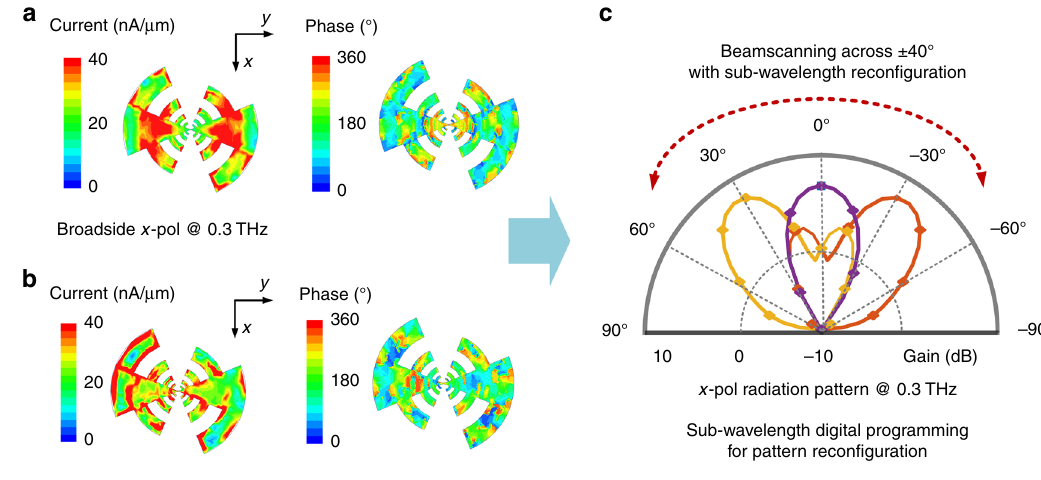
Fig. 2 Direct digital programming of the interface against angle of incidence. The fi gure shows the distribution of amplitude and phase of the impressed surface current under incidence a 0.3 THz at ( a ) broadside and ( b ) at 45° under the optimal detector settings. c The simulated beam pattern of the collective absorption across the senor array shows the ability to orient it across various angles of incidence. Functionally, this is similar to a beam-scanning operation of phased arrays. Here, it is realized with a continuous aperture and subwavelength recon fi guration allowing pattern shaping and frequency agility